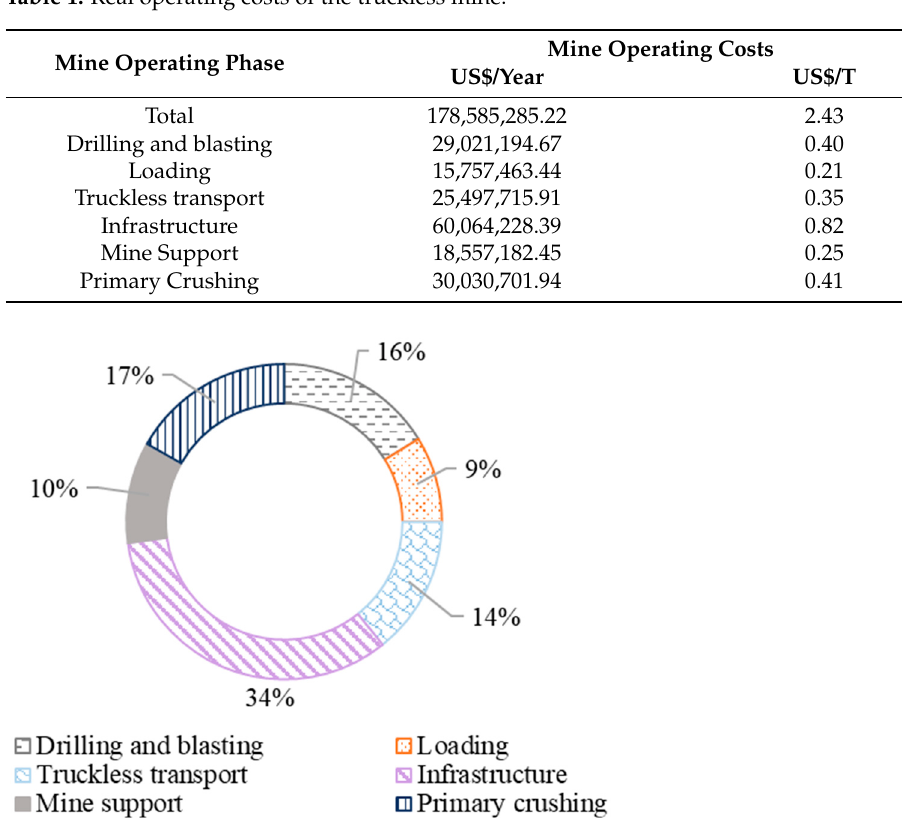
Table 1. Real operating costs of the truckless mine.